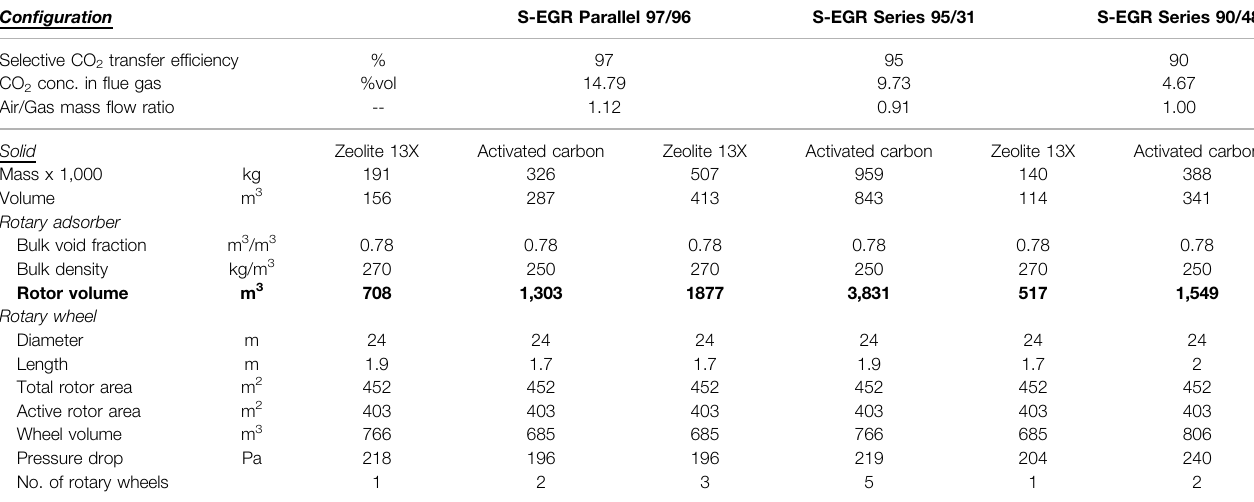
TABLE 3 | Adsorbent requirements and preliminary dimensions of the rotary adsorber, per GT-HSRG train. Con fi